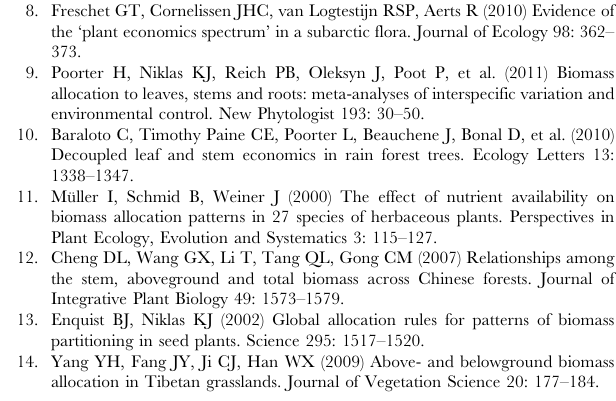
Table S1 The ANOVA results of characteristics of environ- mental variables, dry matter content, functional traits, biomass allocations, and allometry of P. australis in aquatic and terrestrial